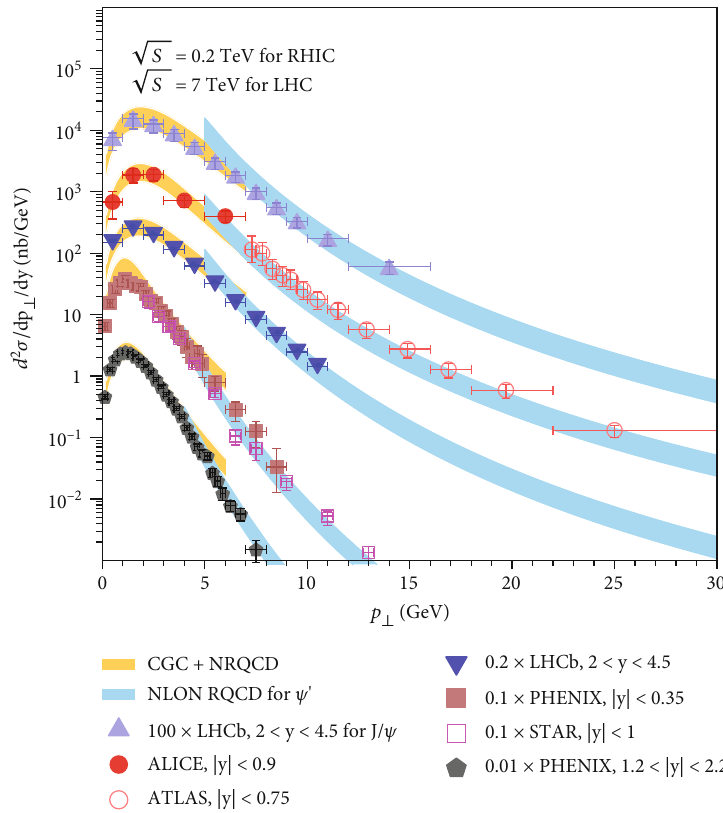
Figure 5: The ψ ð 2 S Þ (top curve) and J / ψ (other four curves) di ff erential cross section as functions of p taken from Ref.